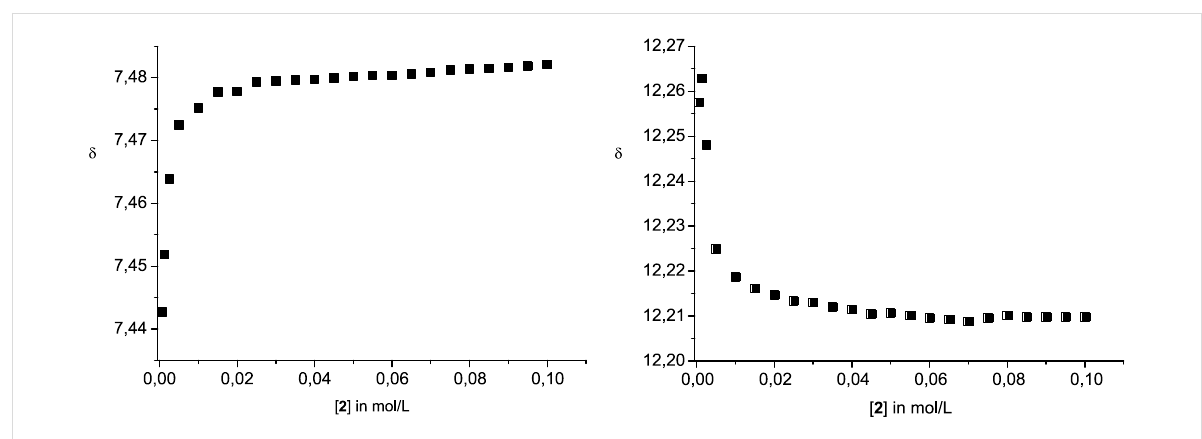
Figure 4: Representative binding isotherm of the aromatic proton d (left) and the indole NH proton (right).